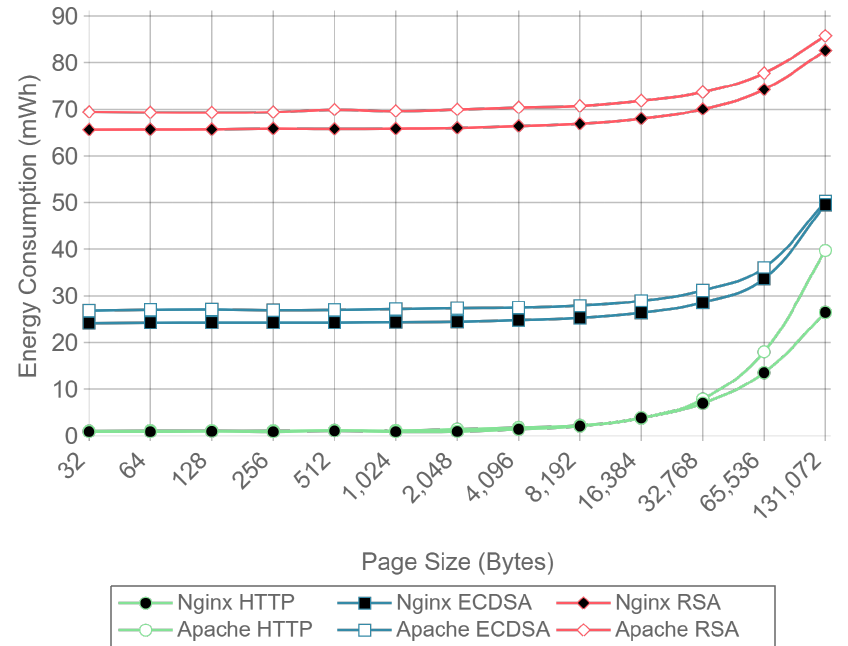
Figure 12. Server-side page size versus energy consumption for Apache2 and Nginx with 128 concurrent